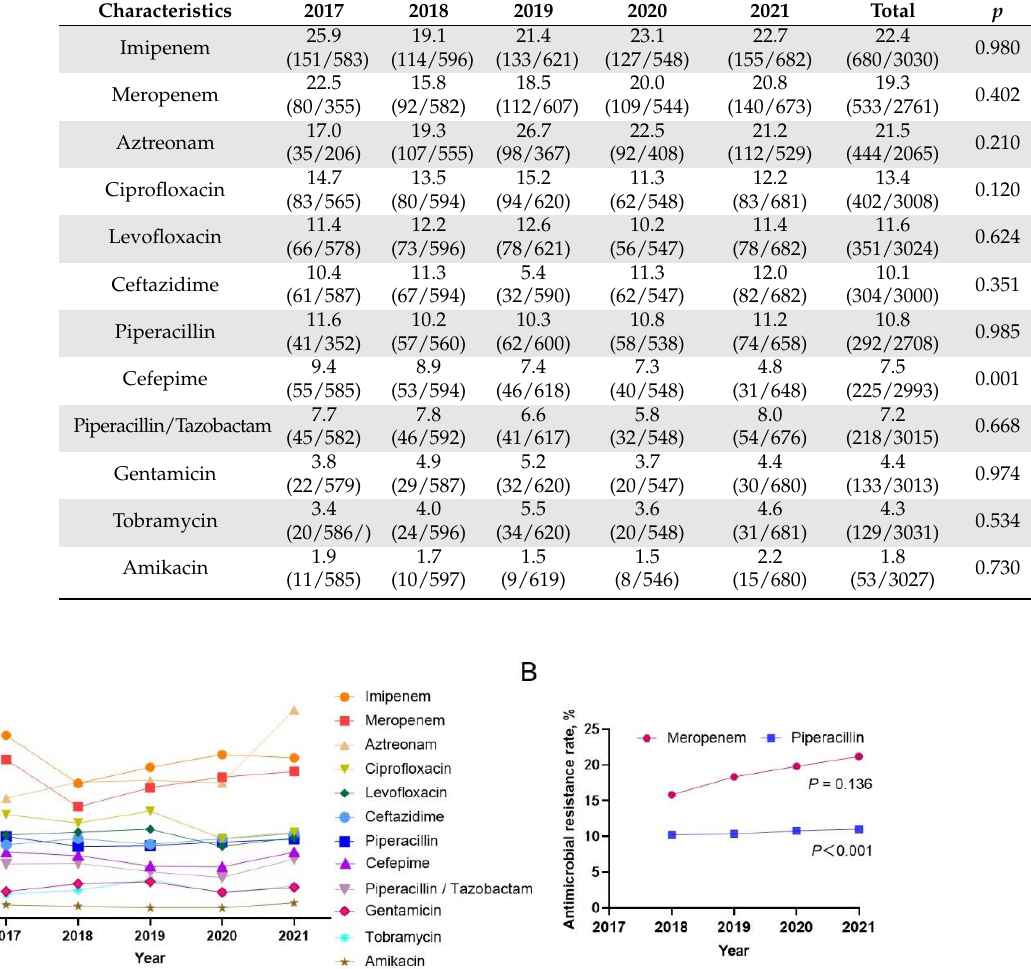
Table 1. Resistance rate of P. aeruginosa to antibiotics in 2017 – 2021 (%). Characteristics